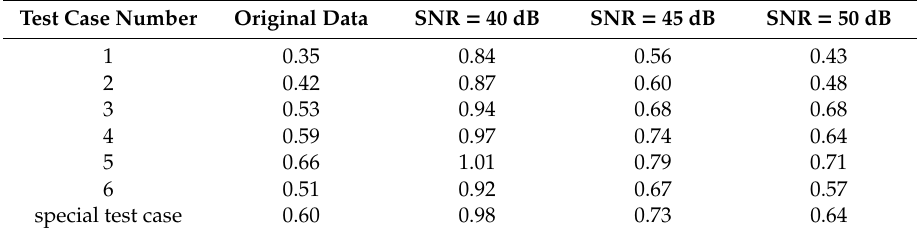
Table 3. Reconstruction errors (%) in seven test cases with eight POD basis vectors.